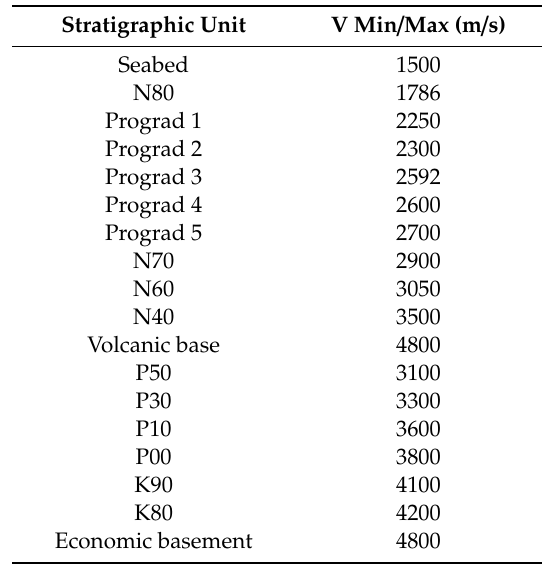
Table 1. Velocity ranges calculated from check-shot data